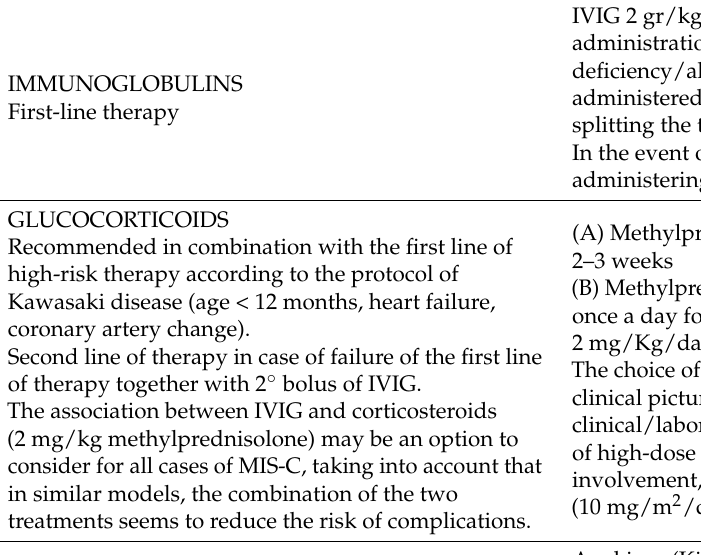
Table 5. Proposal for immunomodulation in multisystemic inflammatory syndrome (MIS-C).